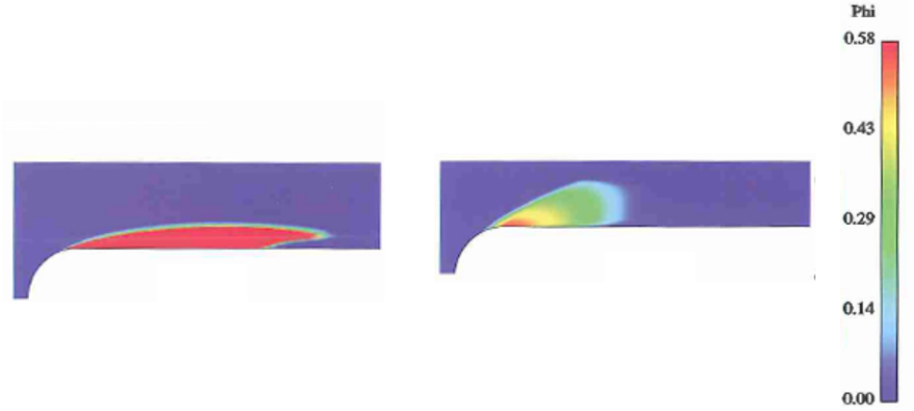
Figure 4. Comparison of void fraction for isothermal cavitation ( left ) and cryogenic cavitation ( right ) [21], Copyright (2005), with permission from